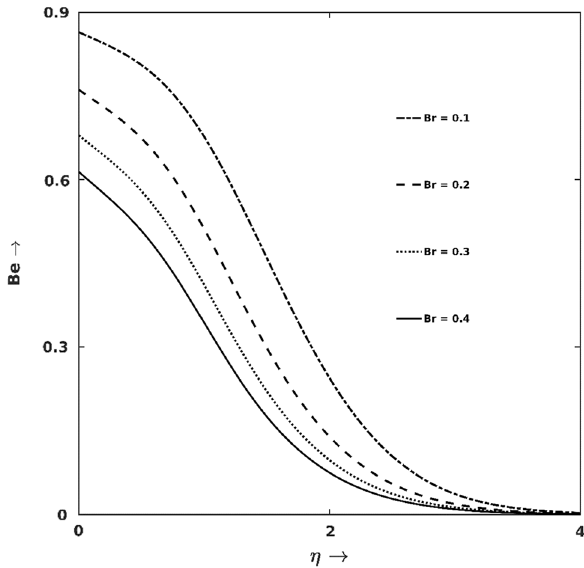
Figure 10. Br effect on Be .